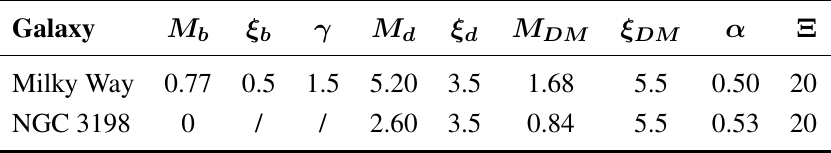
and a = 1 Kpc. (cid:12)